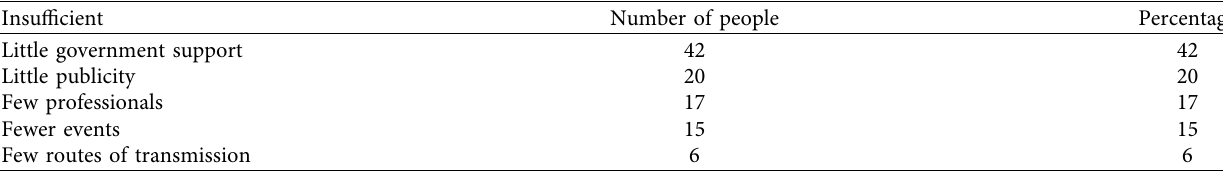
Table 1: Survey of 100 martial arts